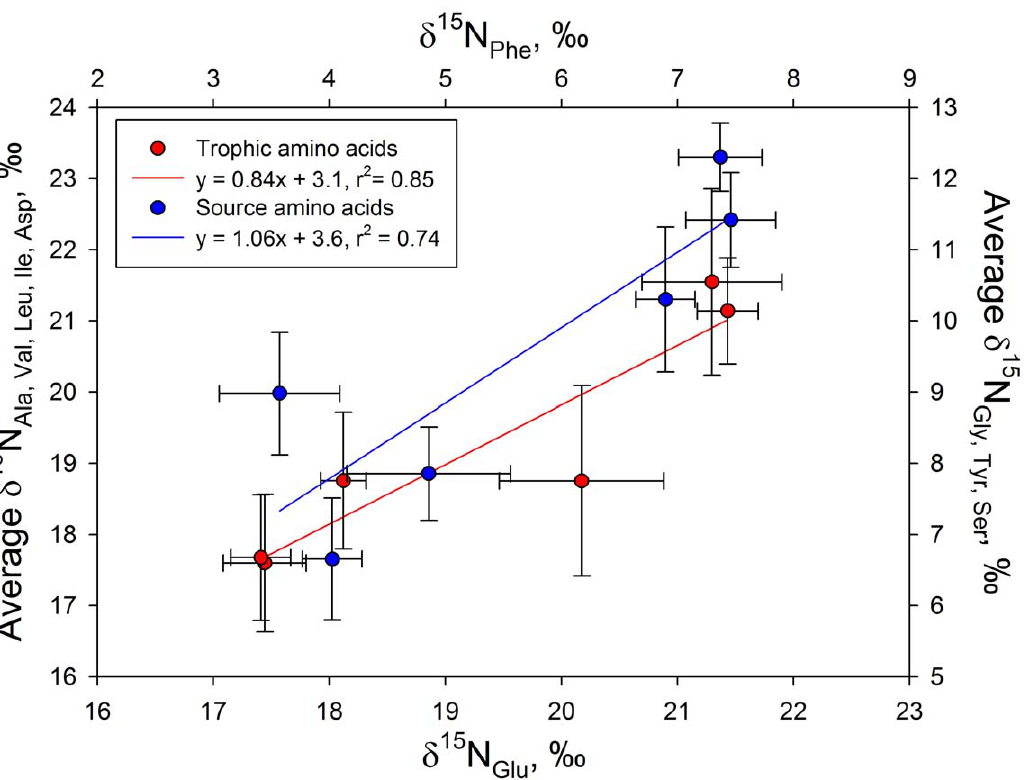
Figure 4. Plot of the d 15 N value of glutamic acid versus the average d 15 N value of the trophic amino acids alanine, valine, leucine, isoleucine and aspartic acid (red), and the d 15 N value of phenylalanine versus the average d 15 N value of the source amino acids glycine, tyrosine and serine (blue). The slopes of the regression lines in this figure are not different at the 95% confidence interval. The satellite- tracked movements of each turtle are shown in Figure 1.